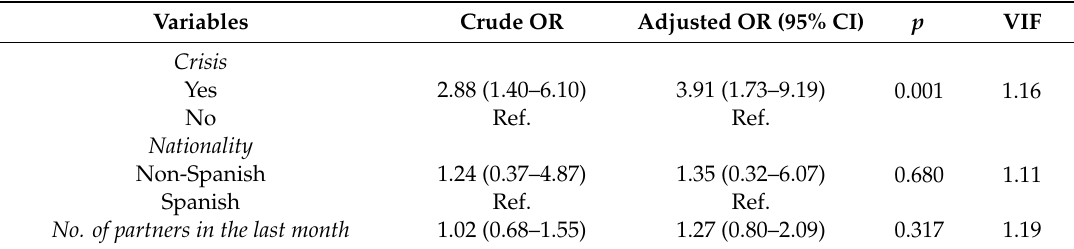
Table 5. Logistic regression for STI diagnosis vs. Crisis.